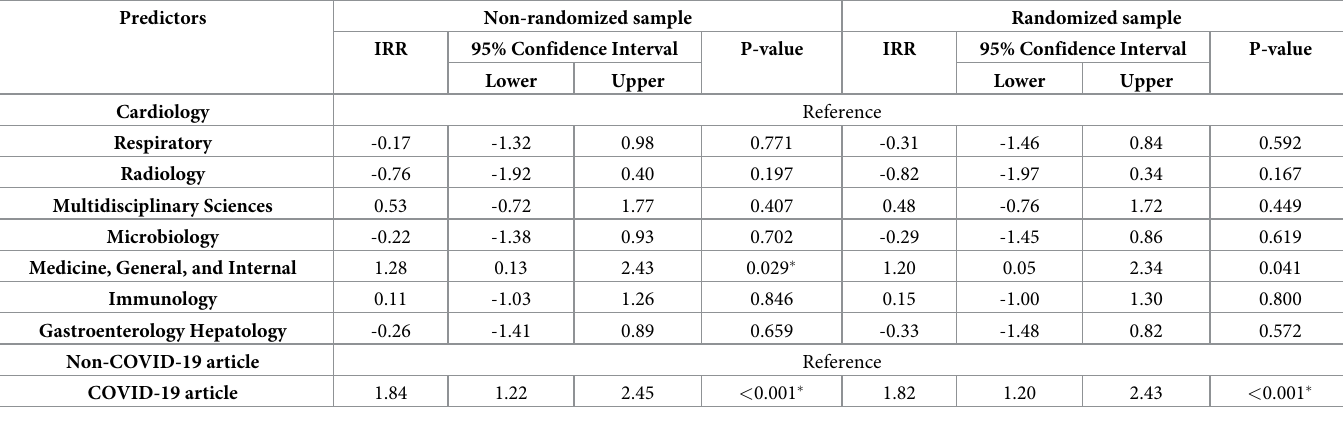
Table 3. Negative binomial regression output reporting independent variable effects on citation